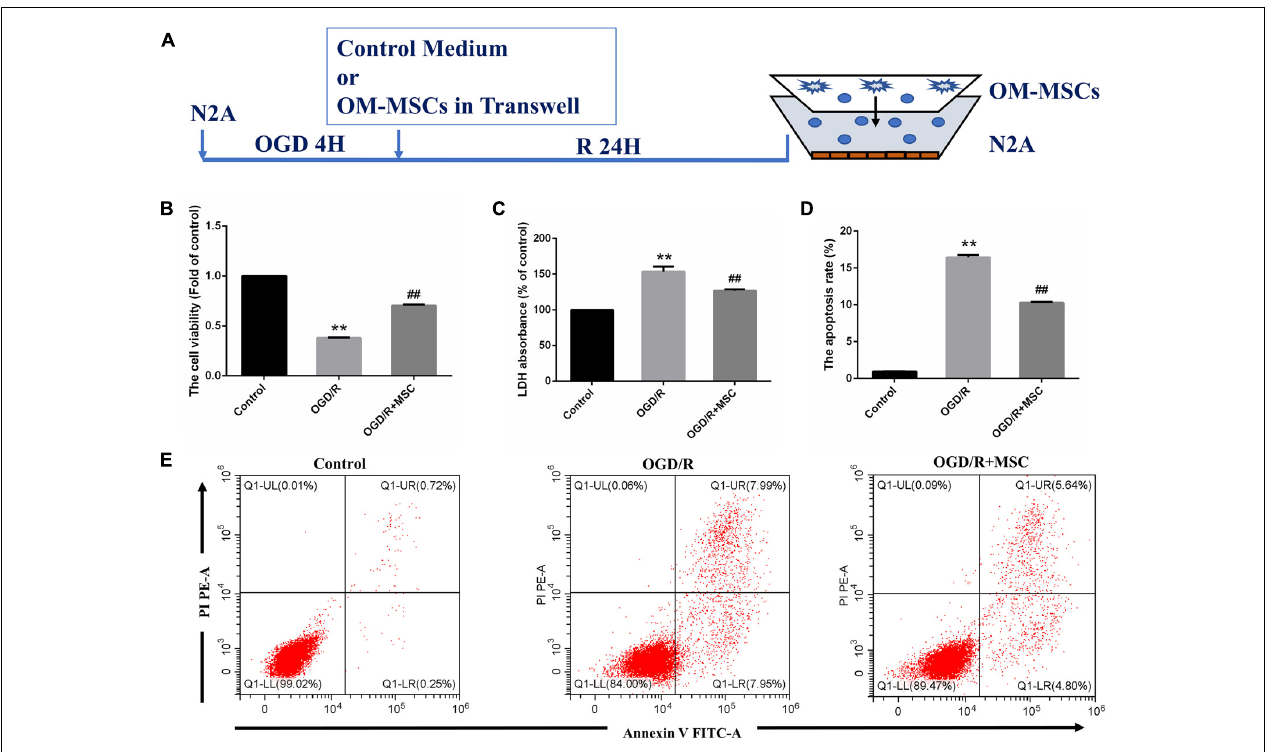
FIGURE 3 | OM-MSCs ameliorated OGD/R-induced N 2 a injury. (A) Schematic representation of the experimental design and the transwell system used for in vitro experiments. (B) Cell viability was determined using the CCK-8 assay, and data are normalized by control cells (the value of control cells was presented as 1.0). (C) Cell necrosis was determined using the LDH assay, and data are expressed as a percentage of the control. (D) Apoptotic cells are represented as the percentage of Annexin-V single-positive plus Annexin-V/PI double-positive cells. (E) Representative plots of FACS by Annexin V–FITC/PI dual staining. All data are displayed as mean ± SEM ( n = 3). ( ∗∗ P < 0.01 vs. control; ## P < 0.01 vs.